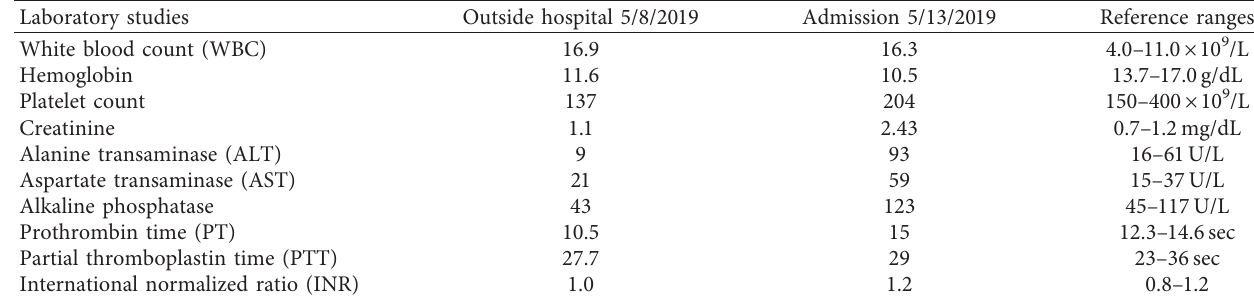
Table 1: Laboratory studies on admission and prior to